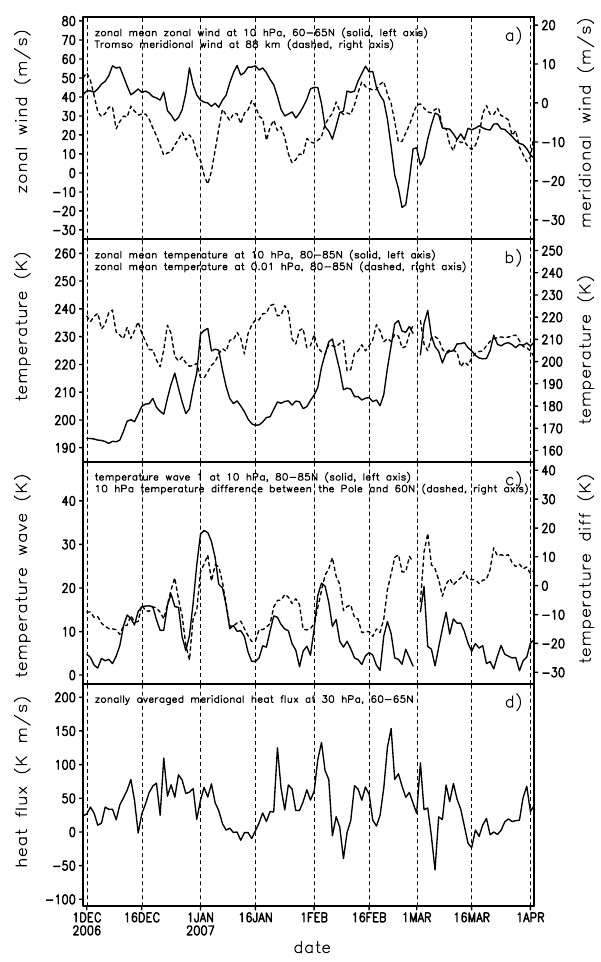
Fig. 3. As in Fig. 2, but for the 2006/2007 winter.